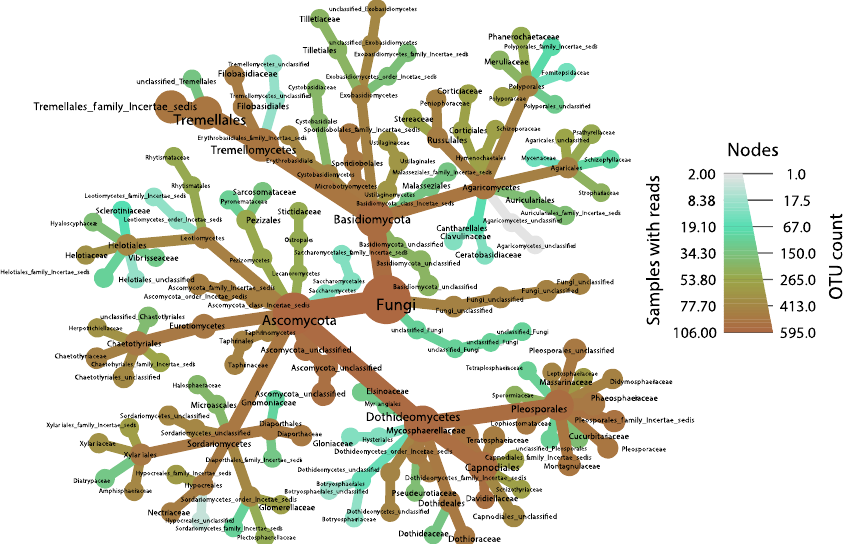
Figure 2. Taxonomic distribution of fungal endophytes within sampled kudzu leaves, as visualized using the program Metacoder, resolved to the family level. Nodes are sized proportional to OTU abundances for each taxonomic rank, and OTUs that are more common throughout our samples fall toward the brown end of the color gradient.